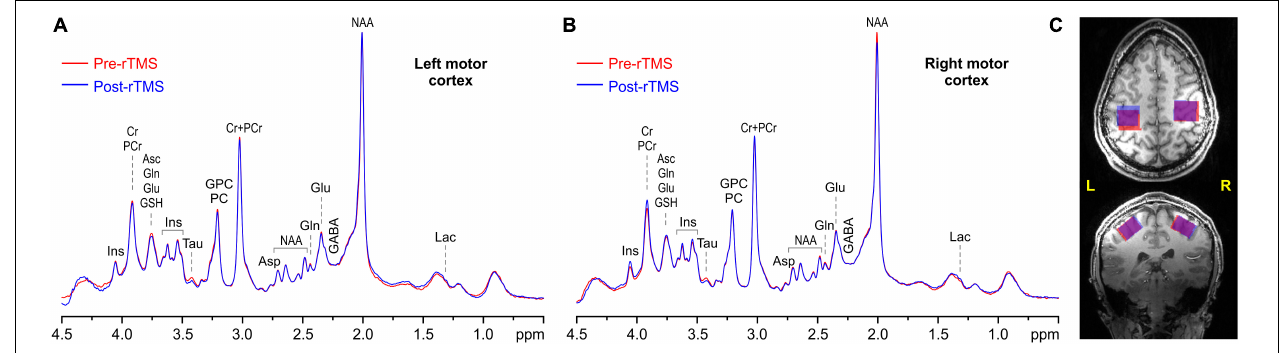
FIGURE 1 | Representative example spectra acquired pre (red) and post 1-Hz rTMS (blue) from the left (A) and right (B) VOIs, along with VOI placements (C) in the motor cortices in axial (top) and coronal (bottom) view (overlap is in purple). MRS acquisition parameters: 7 T, semi-LASER, 64 scans, TR = 9 s, and TE = 28 ms.